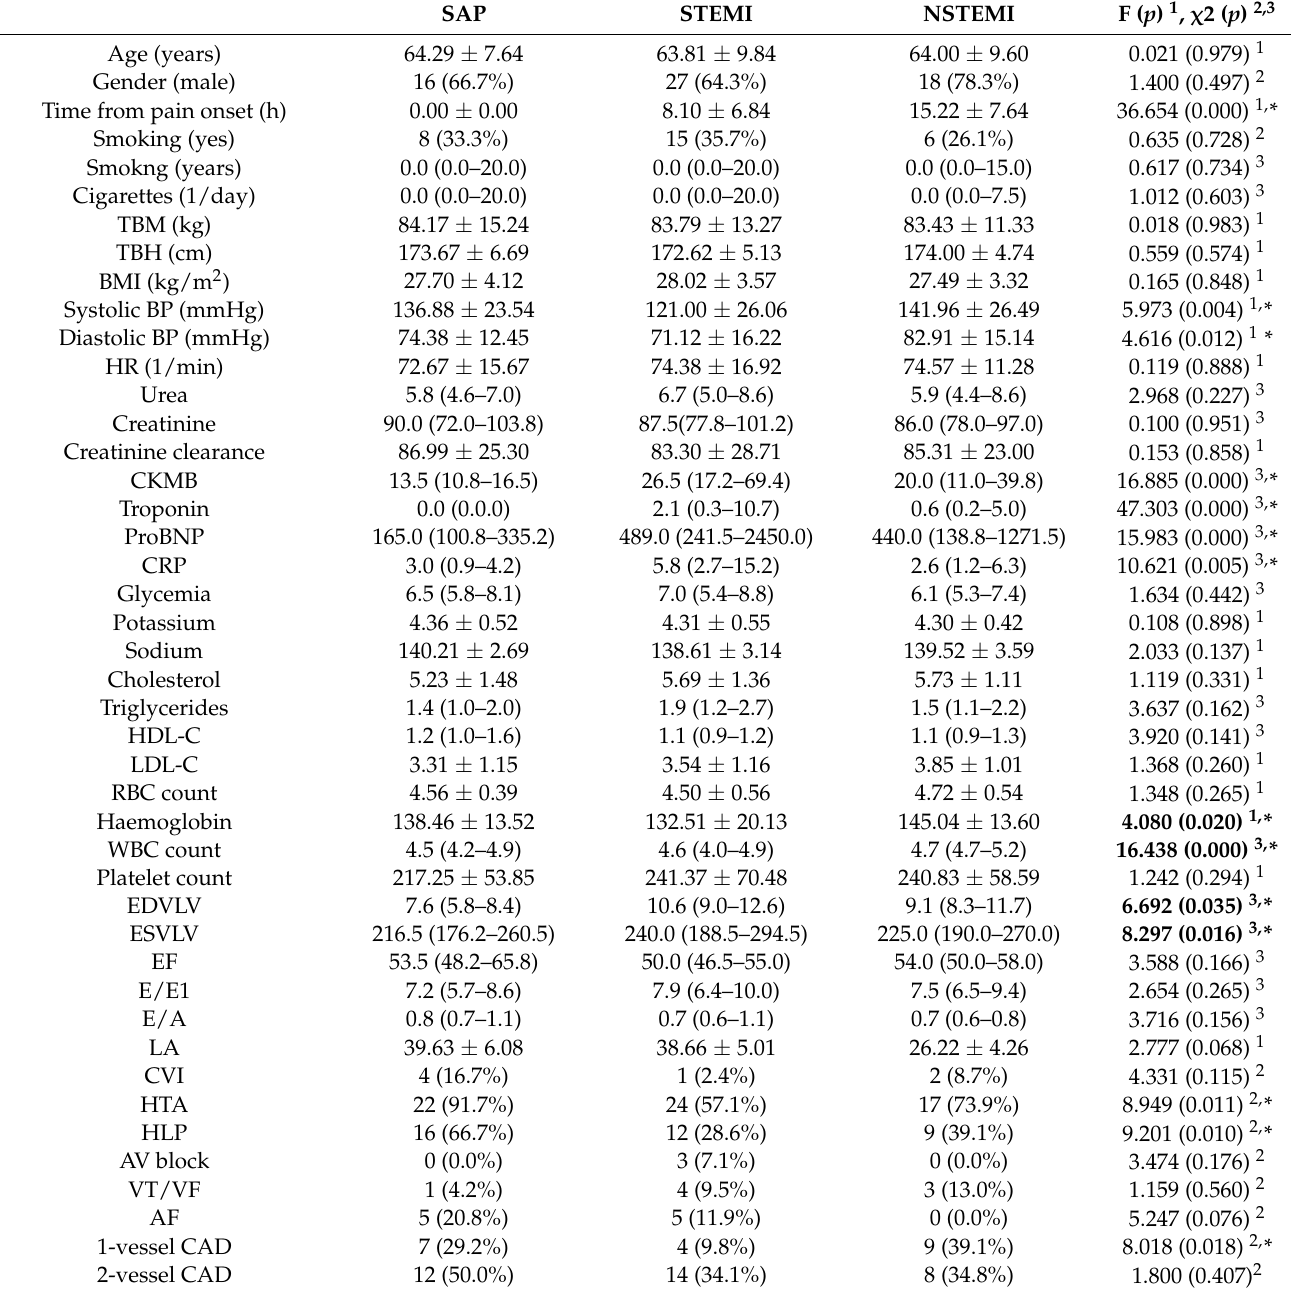
Table 1. Demographic and laboratory data of patients included in the